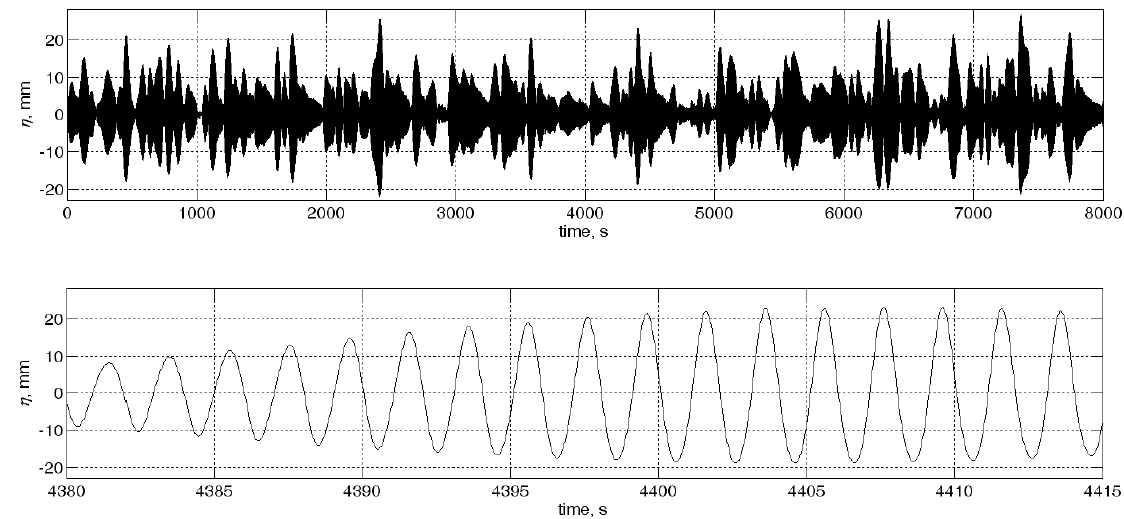
Fig. 4. Reconstructed incident wave (top) and its zoom (bottom).